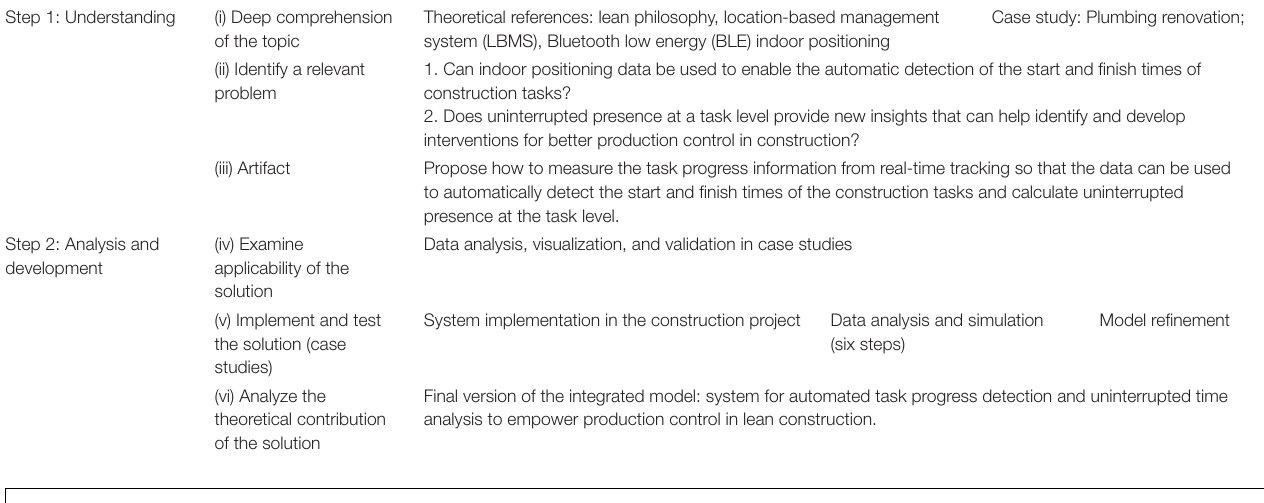
TABLE 1 | Summary of research methods.